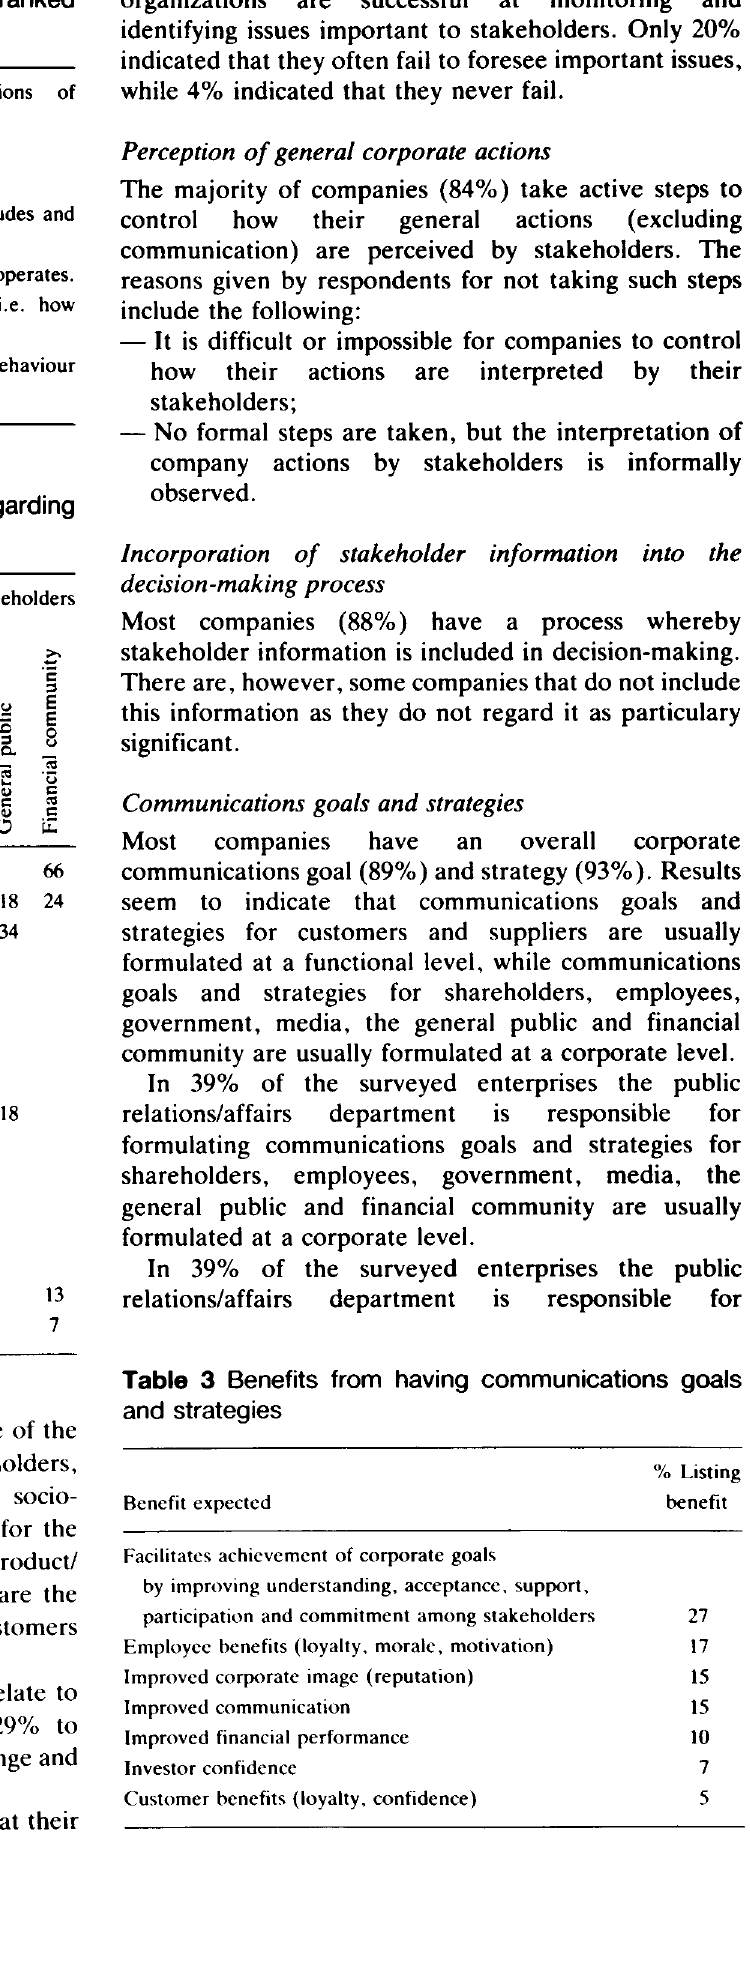
according to frequency